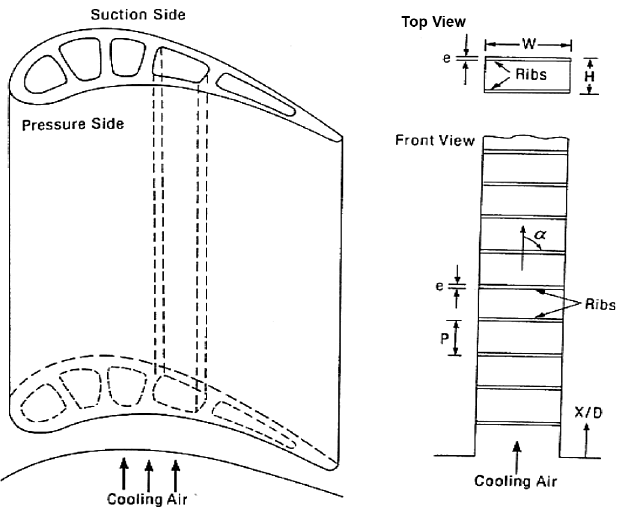
Fig. 6. Series of cooling channels in the gas turbine blade and internal ribs arrangement.